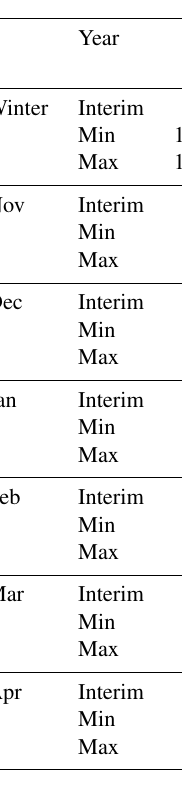
Table 2. Vortex-mean mixing ratio of ClO x integrated over the whole winter (ppbv day) and as monthly mean concentration (ppbv) in the Min, Max and Interim simulations. Percentages in parentheses indicate the effect of SWV concentration changes compared to the Interim